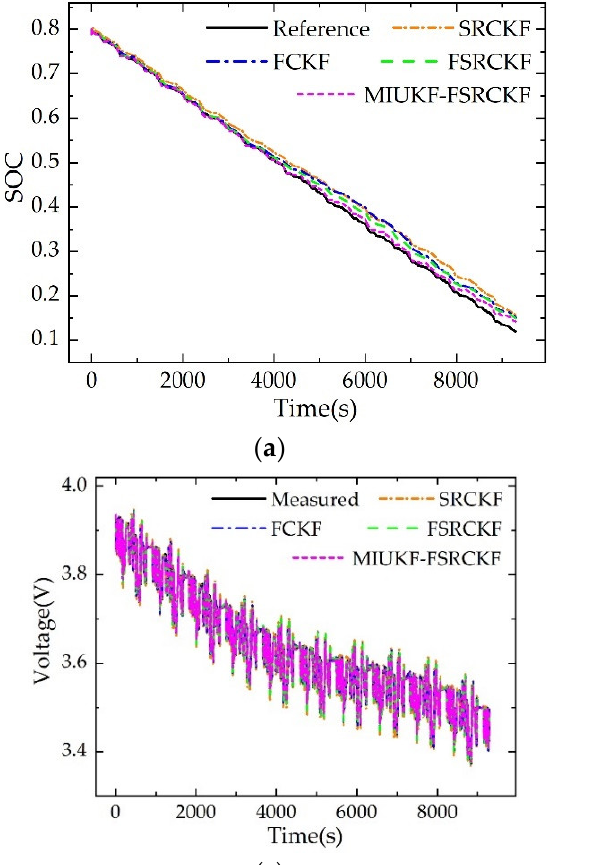
increased by 20% as the initial value of R 0 : ( a ) SOC estimation result; ( b ) SOC error; ( c ) voltage